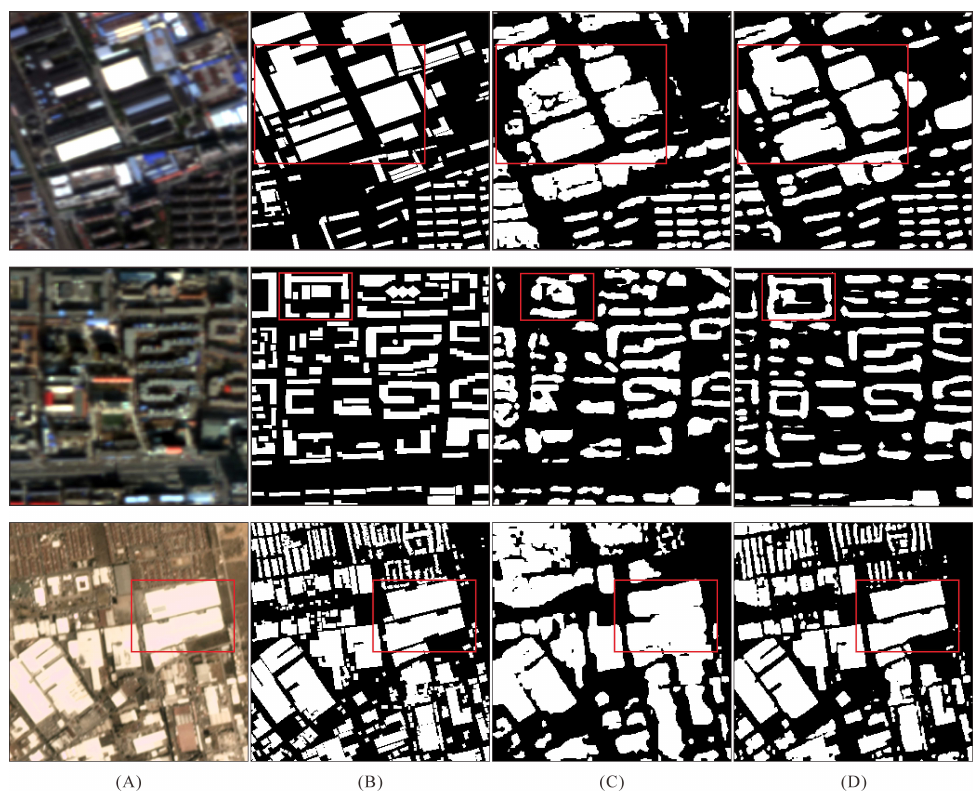
Figure 12. Examples of the ability to capture building shapes. From left to right are ( A ) Image tile. ( B ) Ground truth. ( C ) ASLNet. ( D ) GFANet. ASLNet was proposed to find the regularized shape of buildings. However, it failed to predict accurate building boundaries compared with our method. The red squares indicate our notable